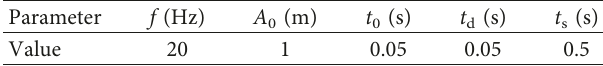
Table 7: Relevant parameters for the dynamic